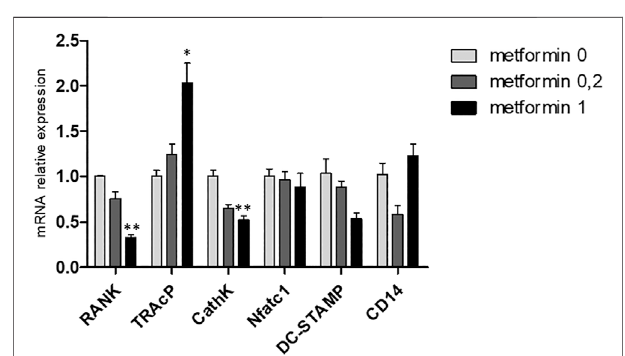
FIGURE 5 | Metformin affects gene expression in M-CSF and RANKL driven osteoclast cultures. Gene expression of RANK, TRAcP, Cathepsin K, NFATc1, DC-STAMP and CD14 at 21 days. Expression of the control, metformin 0, was set at 1.0. Decreased expression of RANK and Cathepsin K was observed and increased expression of TRAcP. *: p < 0.05, **: p < 0.01.